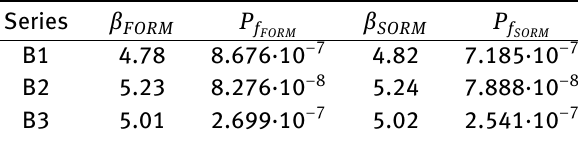
Table 3: Reliability index and failure probability for whole system Series